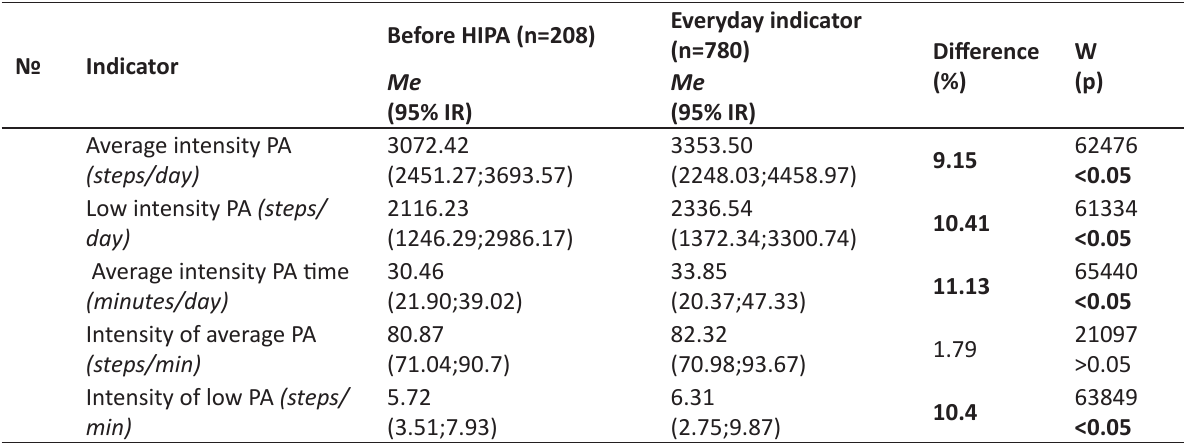
Table 2. Comparison of men’s average and low physical activity before HIPA with every day indicators